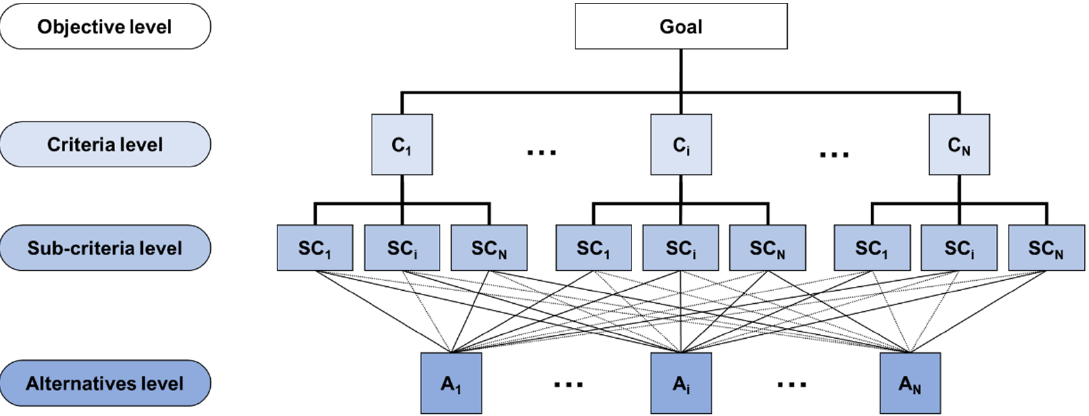
Figure 2. Multicriteria decision making by means of the analytic hierarchy process (from the top: Goal = objective of the analysis; Ci = i-th criterion; SCi = i-th sub-criterion; Ai = i-th alternative).